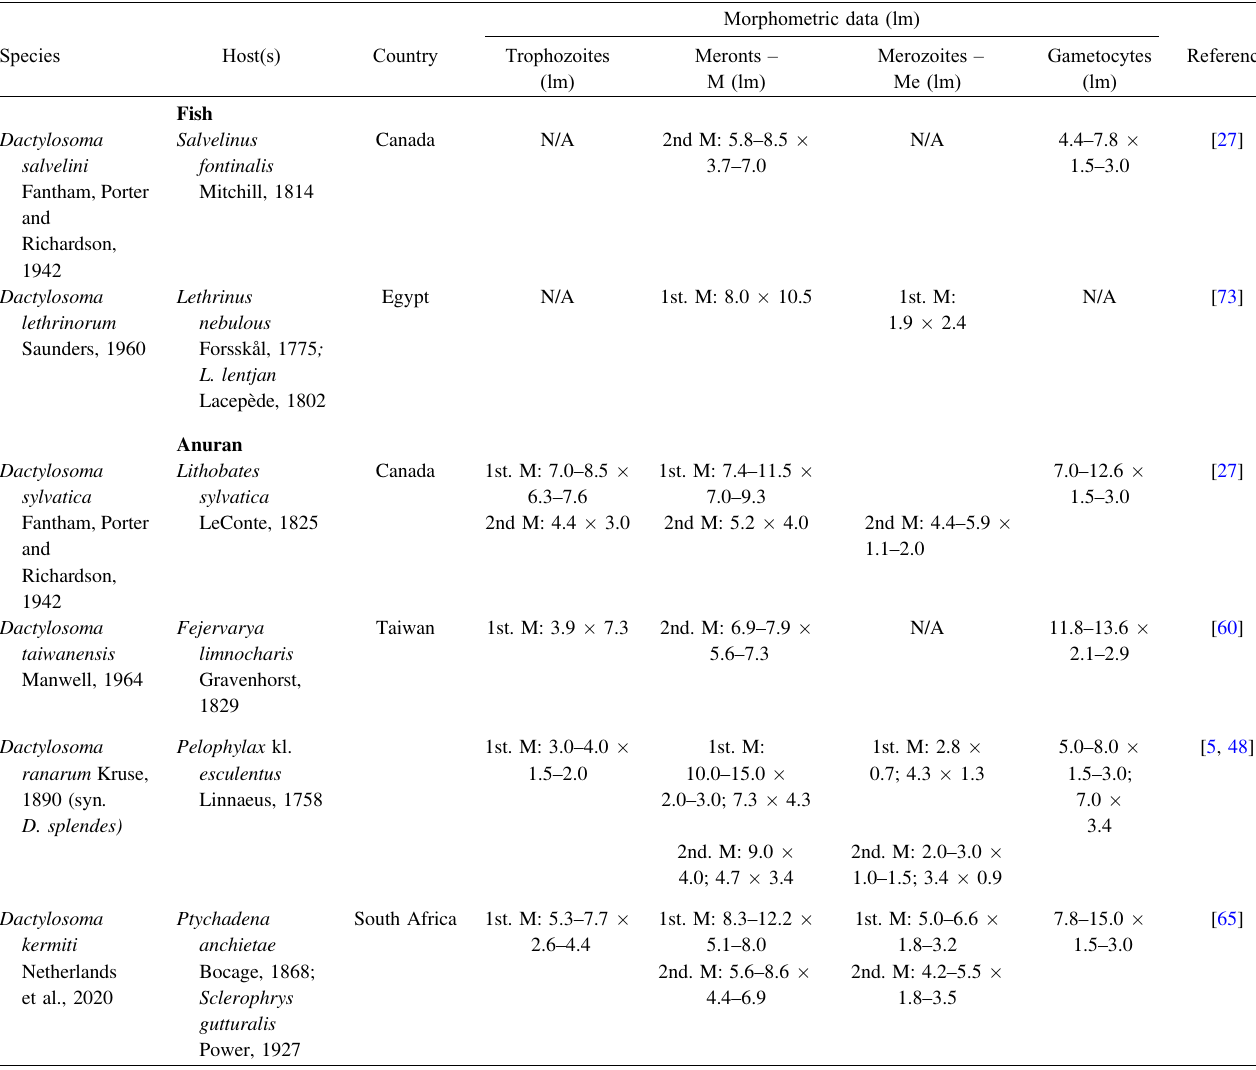
Table 1. Morphometric data on developmental stages of validated Dactylosoma species from fi shes and anuran hosts around the